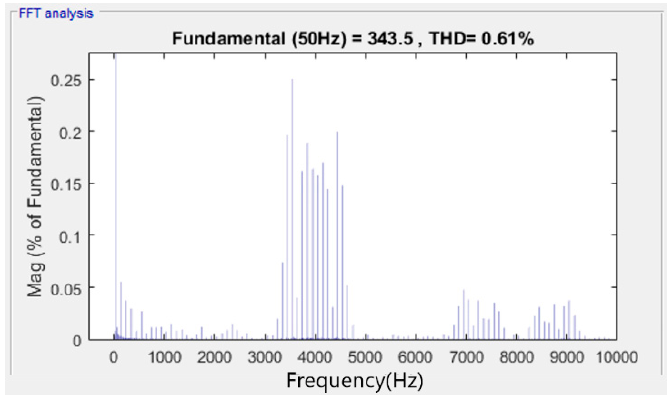
Figure 7. Four H-bridge CHB inverter current THD for PS PWM and equal sources